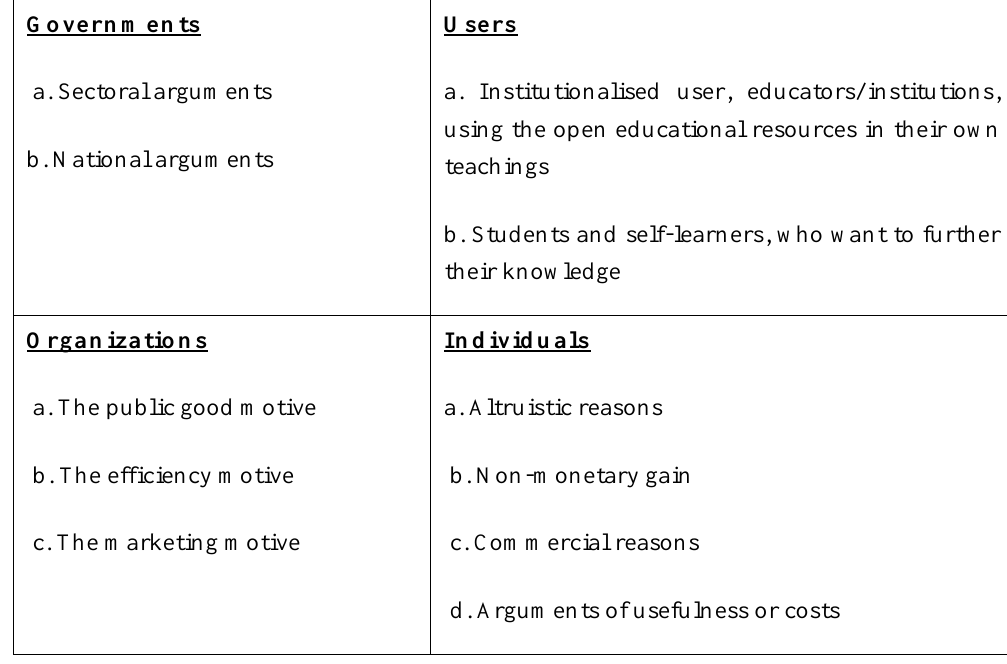
Motives of Participants in